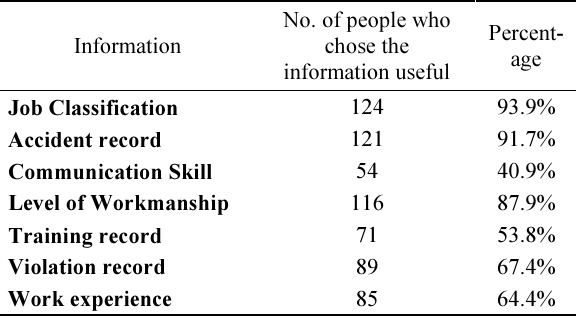
Table 3 . Survey result on useful workforce information